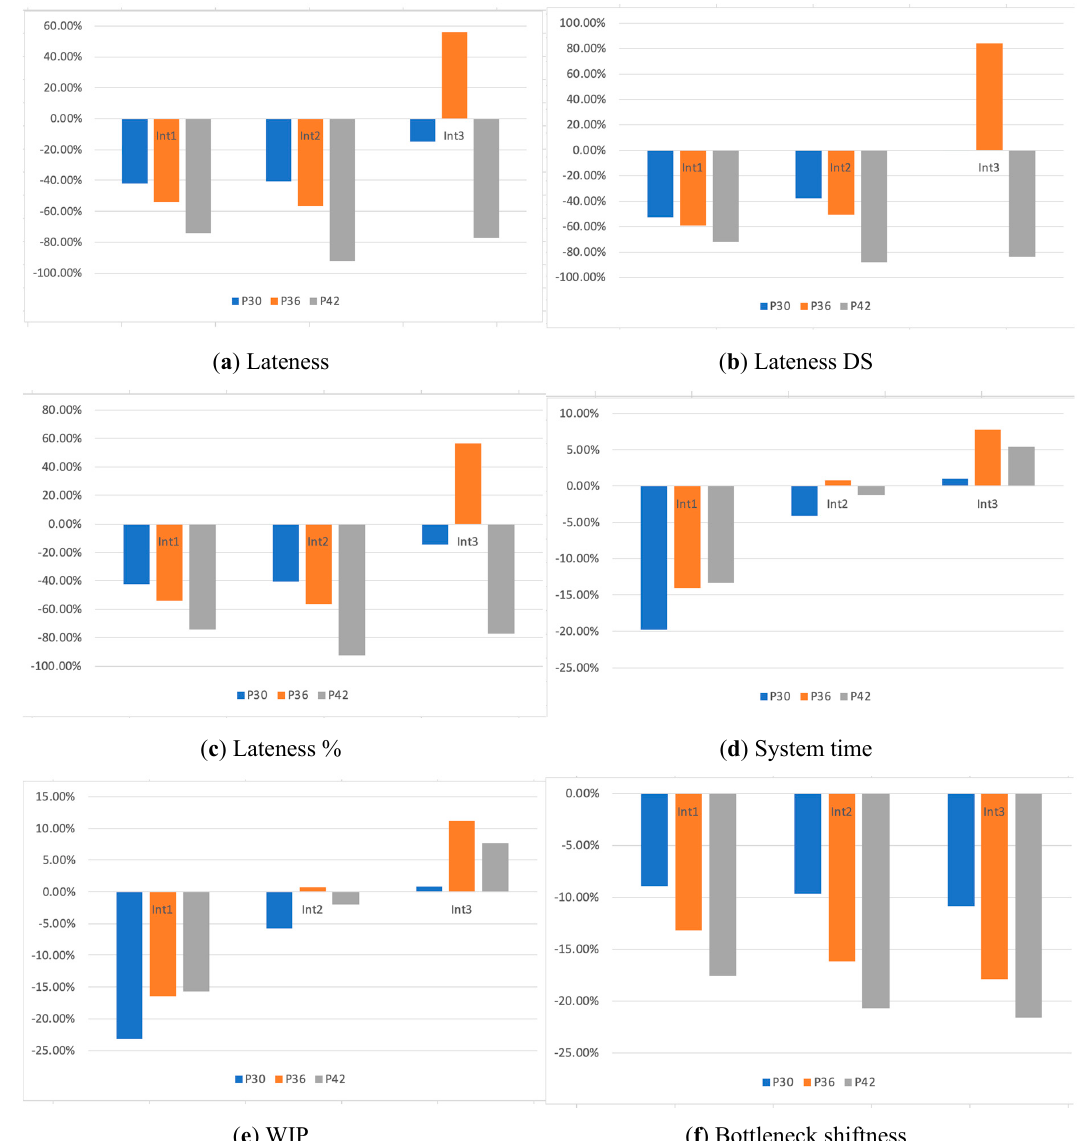
Figure 2. Simulation results. ( a ): Lateness; ( b ): Standard Deviation of the Lateness; ( c ): percentage of parts in lateness; ( d ): throughput time of the manufacturing system; ( e ): Work In Process; ( f ): Bottleneck